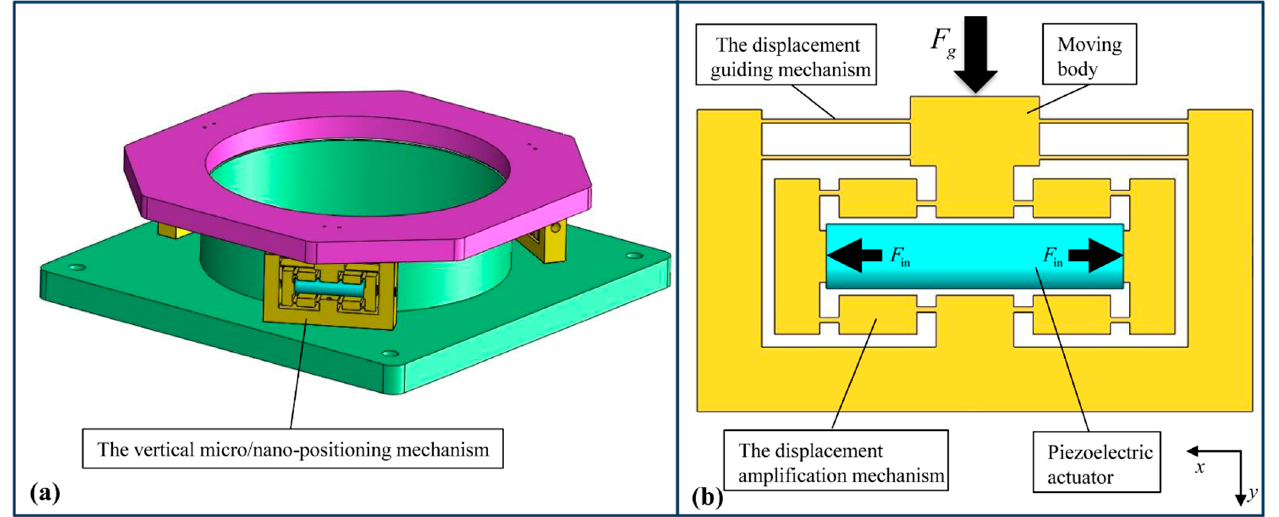
Figure 11. ( a ) The phase-shifting device. ( b ) The vertical micro/nano-positioning mechanism.